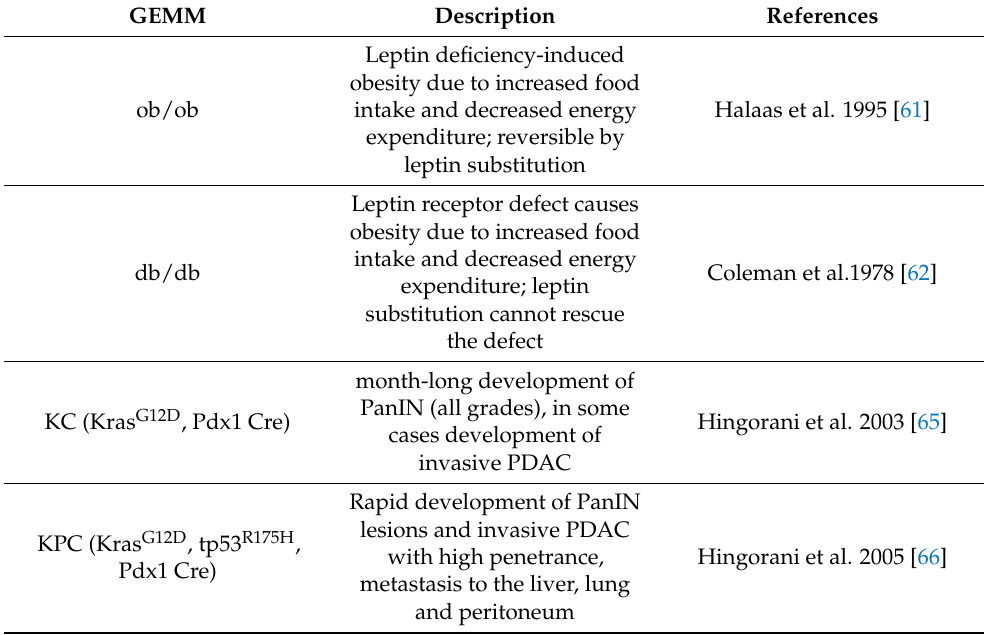
Table 2. Overview of the characteristics of common genetically engineered mouse models (=GEMM) of obesity and pancreatic